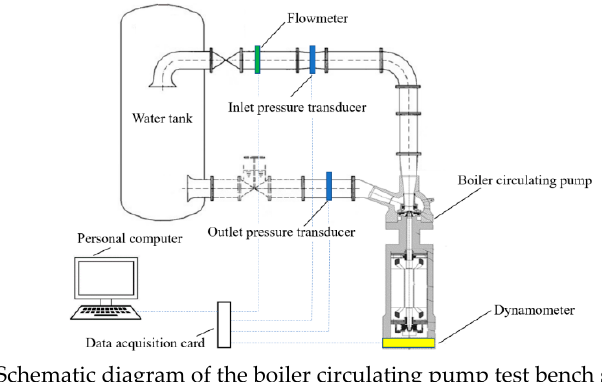
Figure 4. Boundary conditions of boiler circulating pump.